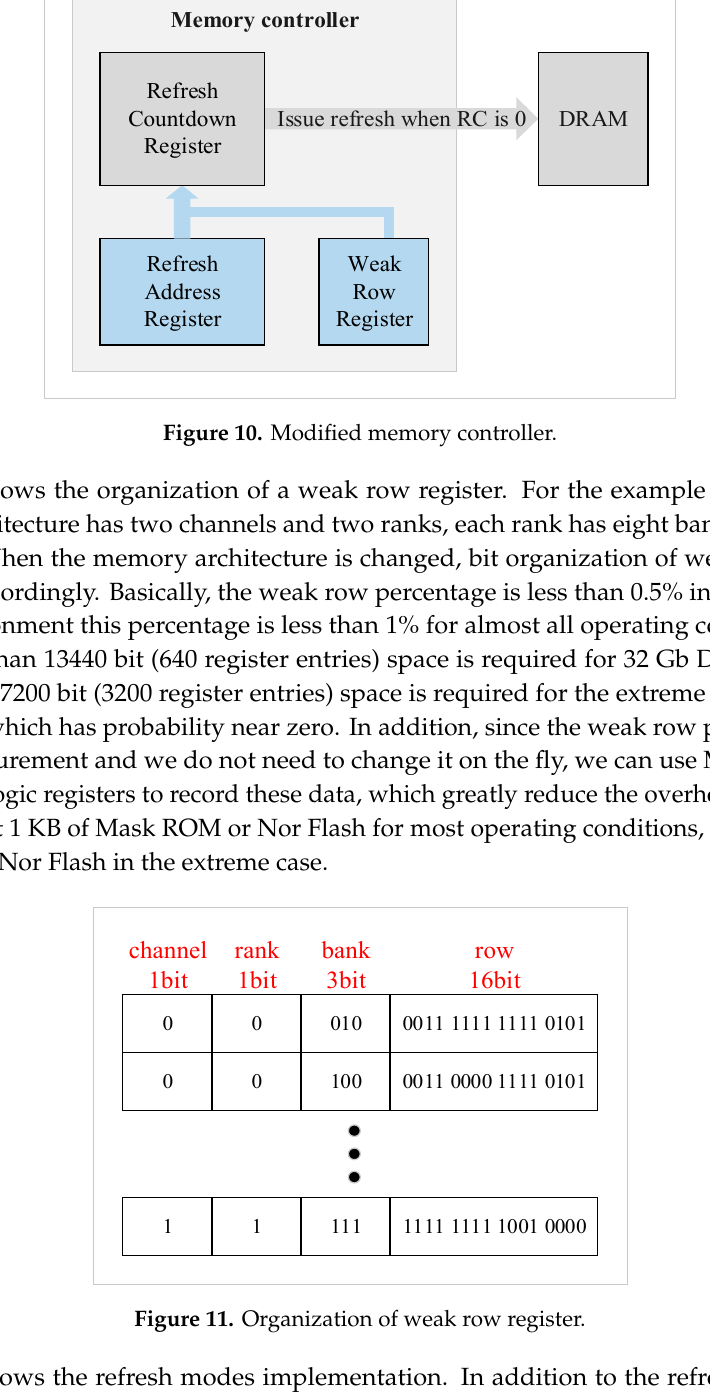
Figure 12. Refresh commands with different flags. 5. Experimental Results We integrated Gem5 [16] and DRAMSim2 [17] as our simulation environment, Figure 13 shows our evaluation flow. Gem5 provided the execution trace and system performance in terms of instructions-per-clock (IPC), and DRAMSim2 provided a detailed active power, refresh power, and background power. We applied eight evaluation benchmarks from SPEC 2006, including four memory-bound benchmarks (mcf, lib, sjeng, cact) and four CPU-bound benchmarks (cal, xal, sop, bzip2). We used the default CPU and memory architecture settings of Gem5 and DRAMSim2, DRAM specification was based on the Micron MT41K1G8 datasheet [1], and the system configurations are shown in Table 3. Our experiments only classify memory cells into two categories: weak cells and normal cells, because more levels of weakness just increase the complexity of the refresh control but